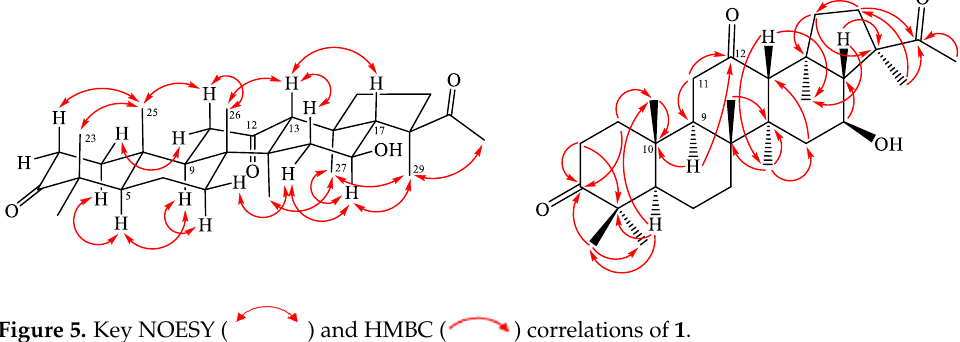
Figure 5. Key NOESY ( ) and HMBC ( ) correlations of 1 . Figure 3. Key NOESY ( ) and HMBC ( ) correlations of 1 . Figure 3. Key NOESY ( ) and HMBC ( ) correlations of 1 . ) correlations of 1